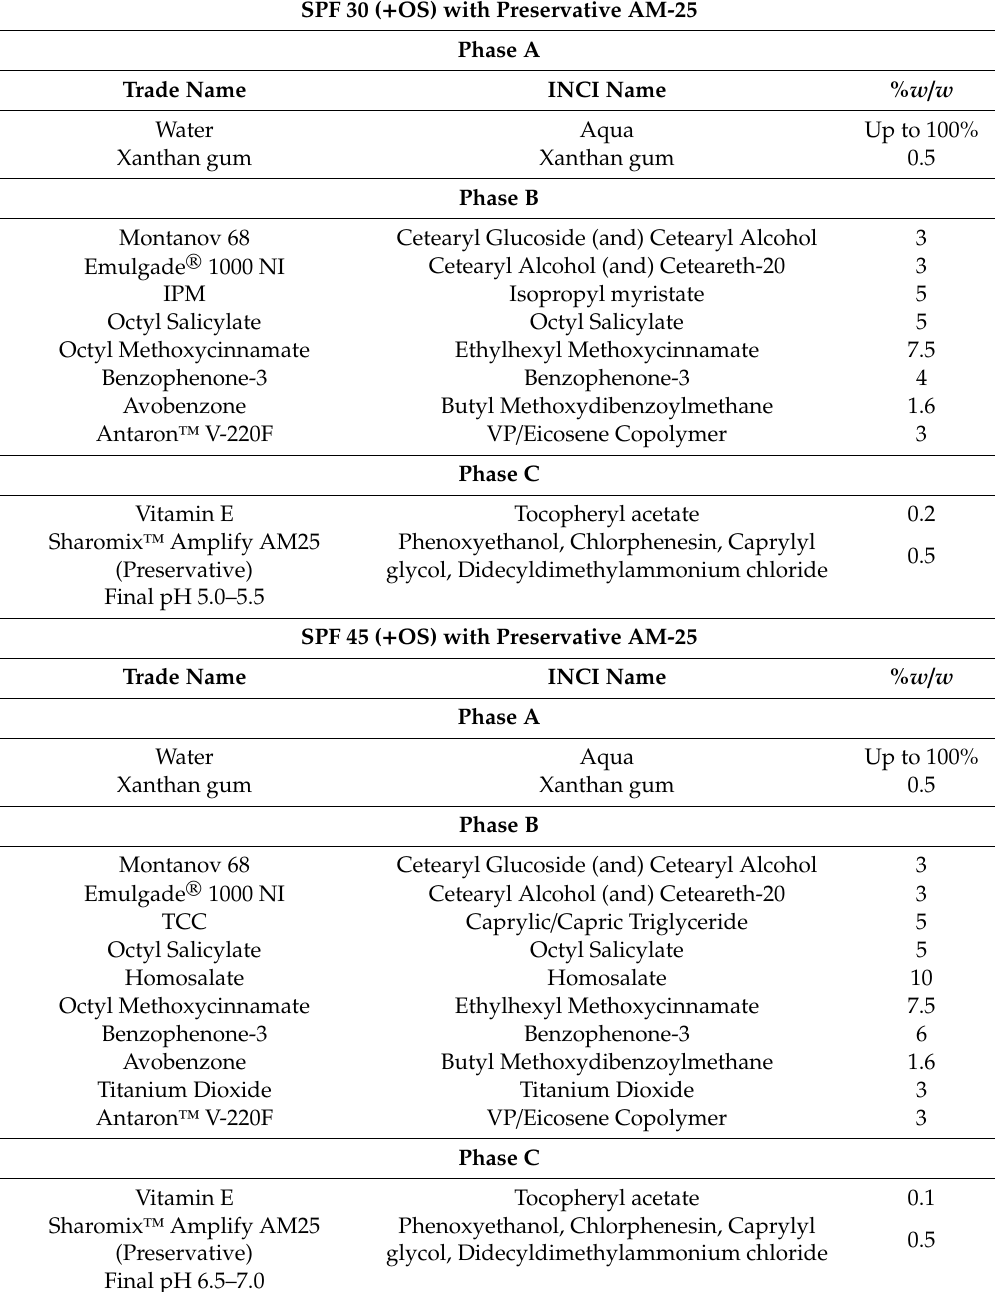
Table 1. Ingredients within each of the formulations used in this study, SPF 30 with octyl salicylate (OS) ( + OS), SPF 45 with OS ( + OS), and basic cream with or without OS or homosalate (HS) ( +/ − OS / HS). SPF 30 ( + OS) with Preservative